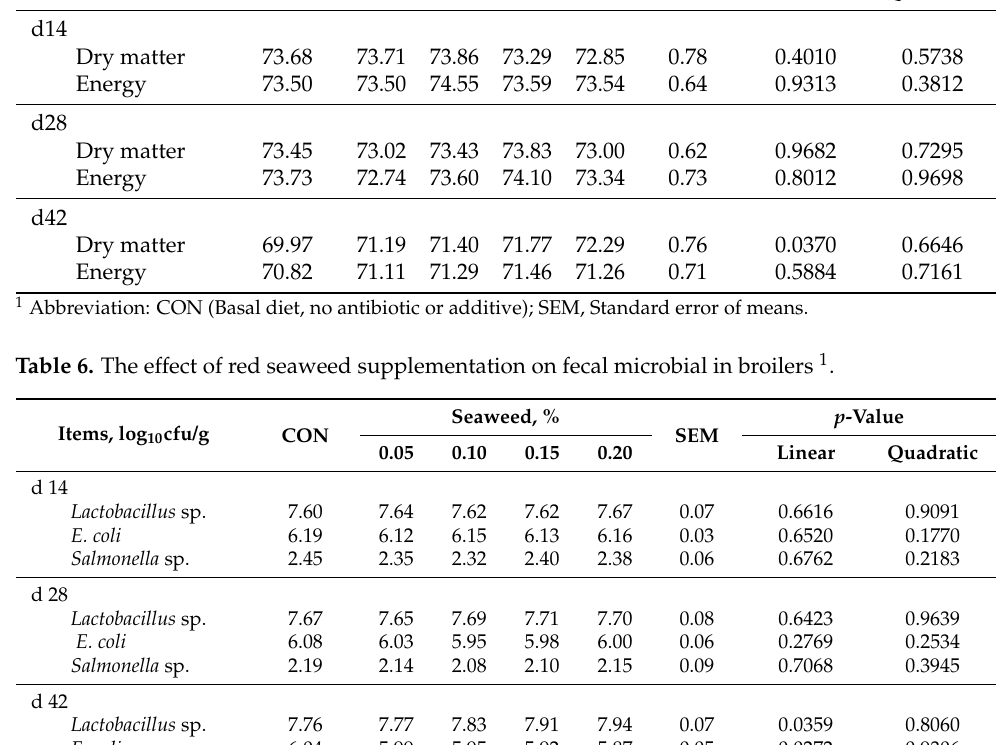
p -Value Seaweed, % SEM